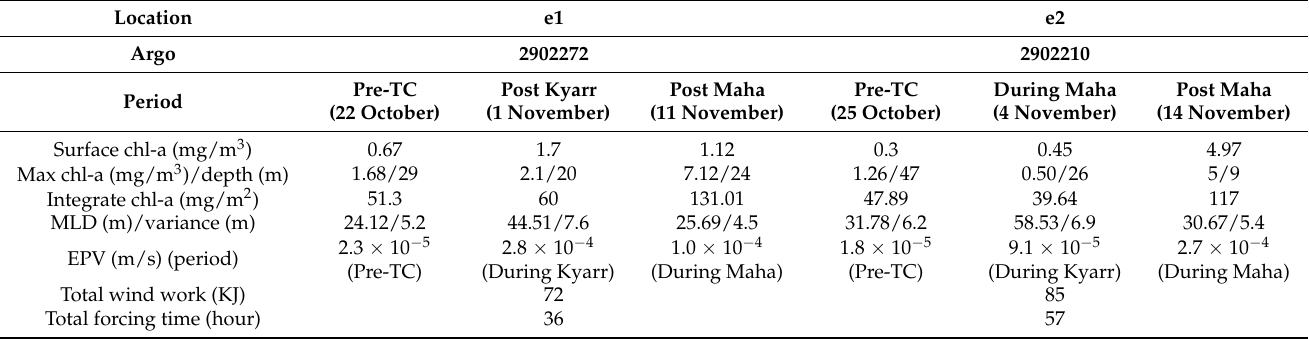
Figure 1. The study area (black rectangle) in the Arabian Sea (AS). The paths of the two sequential TCs in 2019; the black and orange lines represent the tracks of TCs Kyarr and Maha, respectively. The interval between adjacent circles is 6 h, and the color of the circle indicates the intensity of the TC. The dotted lines represent the location of the cold eddies e1, e2, and e3 (1 November 2019–7 November 2019). The Bio-Argo floats are represented by various colored symbols, 6 Bio-Argo floats were selected among them. The small (large) symbols represent the location of Bio-Argo floats during pre (post)-TC Kyarr. Table 1. Statistical results of the Bio-Argo floats.